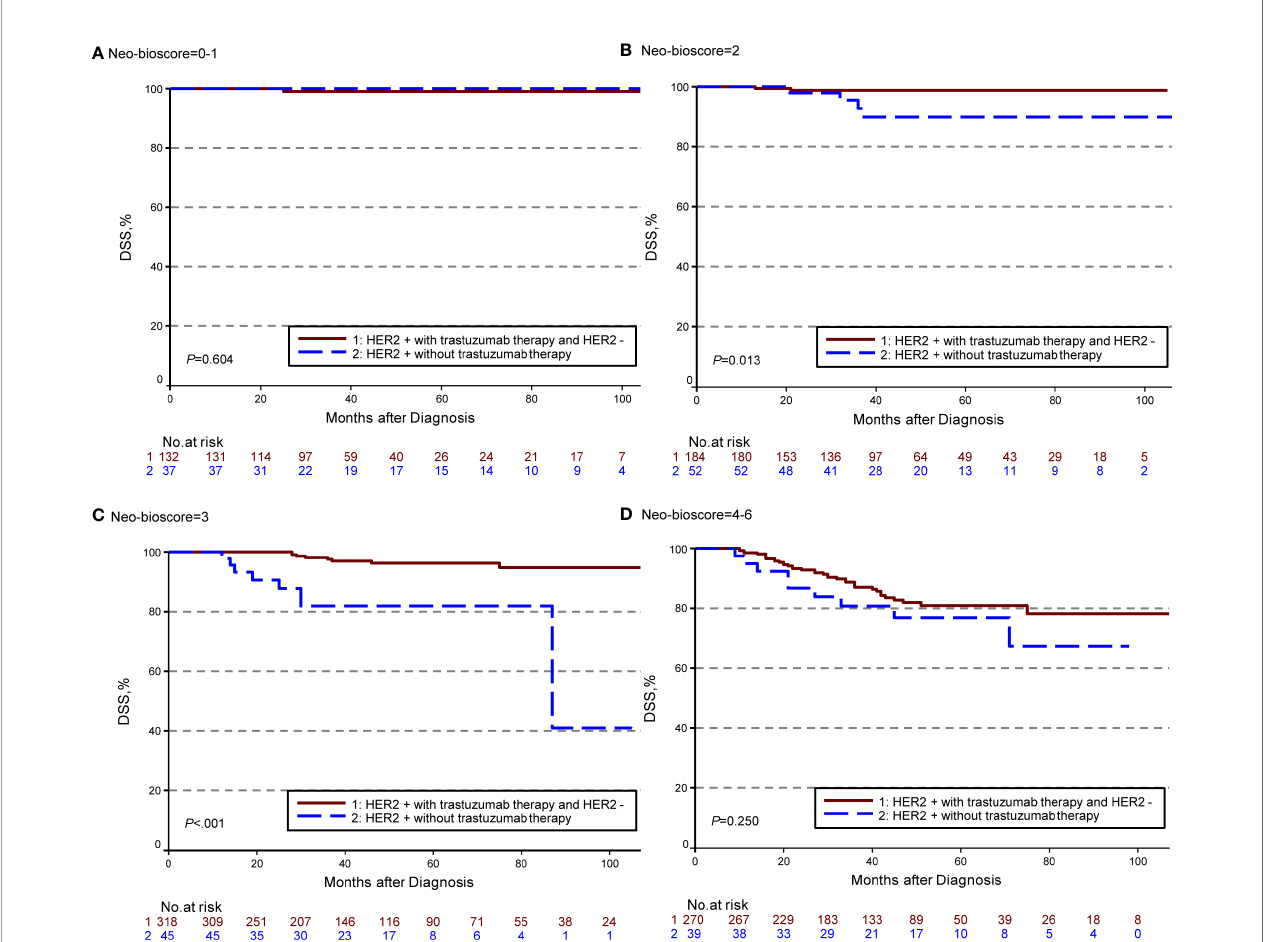
FIGURE 4 | Kaplan – Meier survival curves for disease speci fi c survival (DSS) determined by Neo Bioscore staging system for different HER2 status subgroup. Group 1: HER2-positive patients with trastuzumab therapy and HER2-negative patients; Group 2: HER2-positive patients without trastuzumab therapy. (A) DSS of different HER2 status subgroup in Neo-Bioscore scores 0 and 1; (B) DSS of different HER2 status subgroup in Neo-Bioscore score 2; (C) DSS of different HER2 status subgroup in Neo-Bioscore score 3; (D) DSS of different HER2 status subgroup in Neo-Bioscore scores 4, 5, and